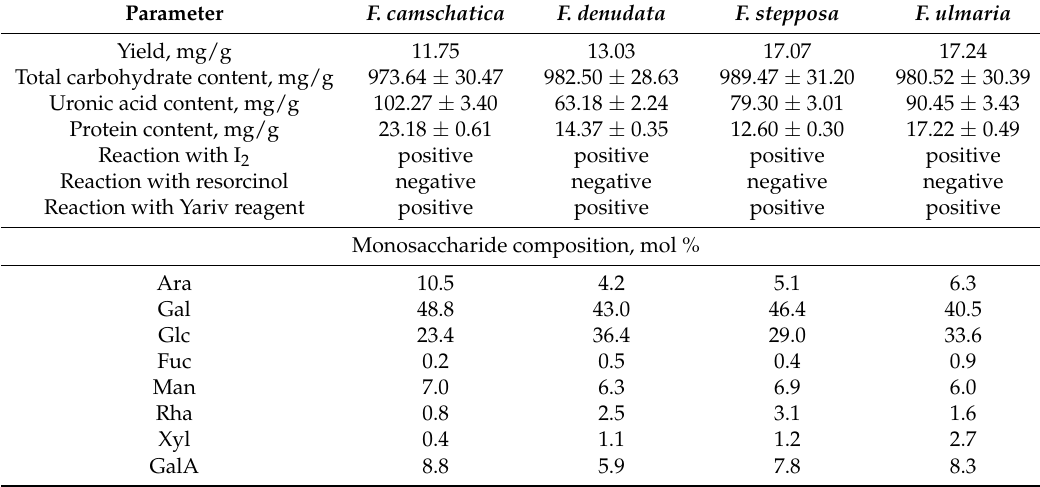
Table 5. General parameters and monosaccharide compositions of water soluble polysaccharide fractions of four meadowsweet floral tea decoctions.